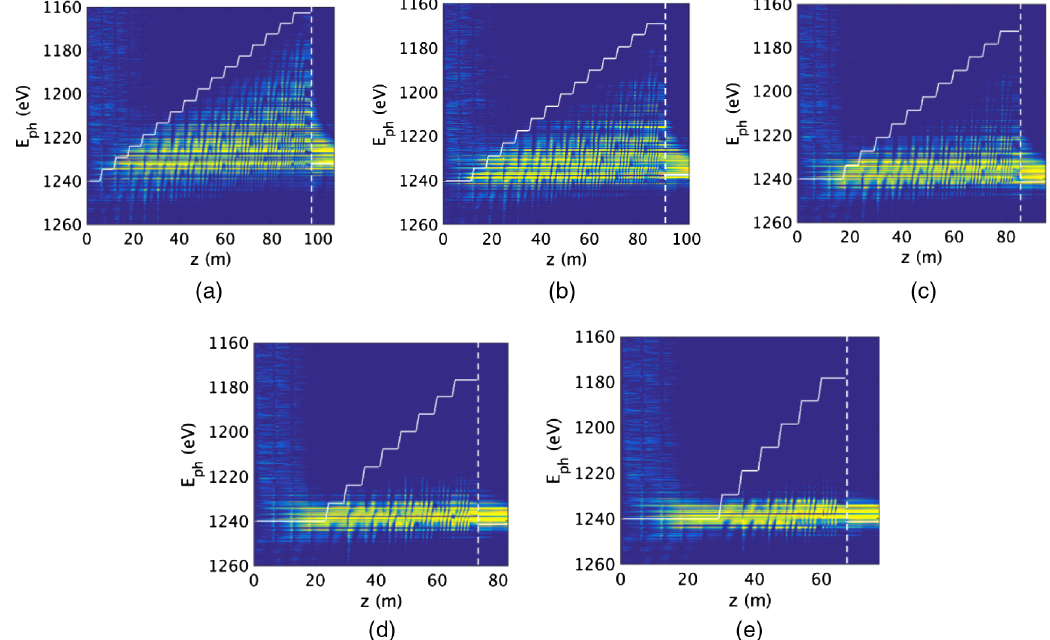
¼ 0 ) and the UT ¼ 1 , (c) N ¼ 2 , (d) N ¼ 3 , and (e) N ¼ 4 . White line (stair shape): resonance UT UT UT UT